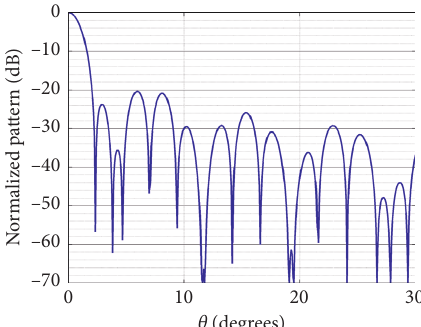
Figure 4: The array factor for N � 64 and M � 34. The 3 rd and 4 th SLLs are approximately